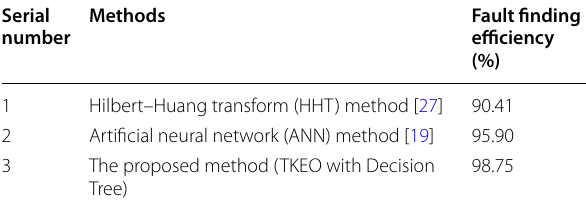
Table 10 Comparison in terms of efficiency of the proposed method with existing methods Serial Methods number